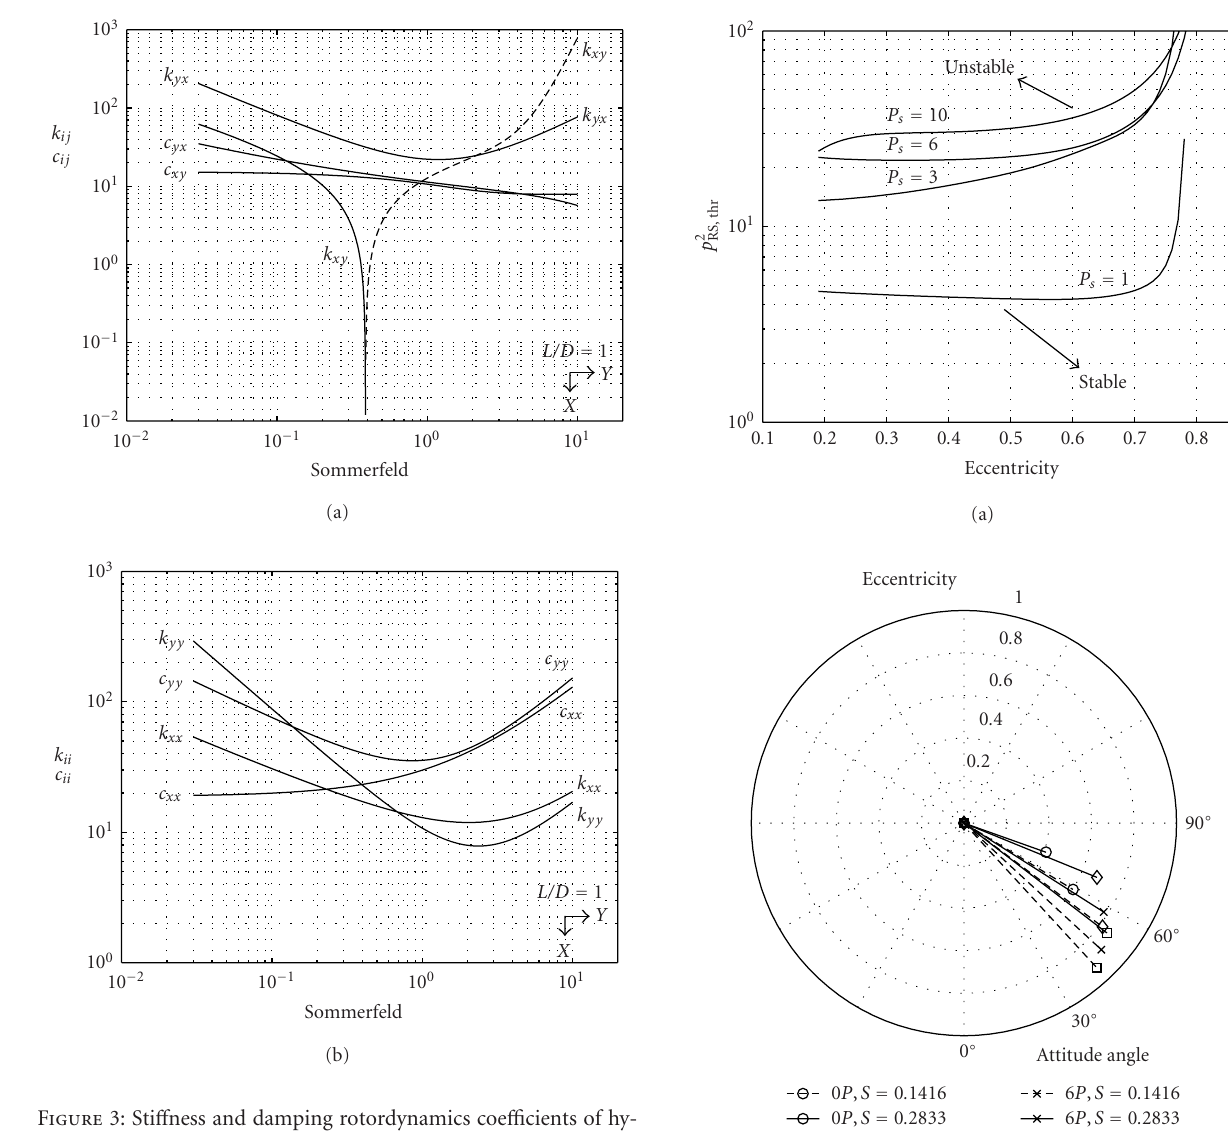
Figure 3: Sti ff ness and damping rotordynamics coe ffi cients of hy- brid bearing design for P s = 10: (a) cross-coupled coe ffi cients and (b) direct coe ffi cients.